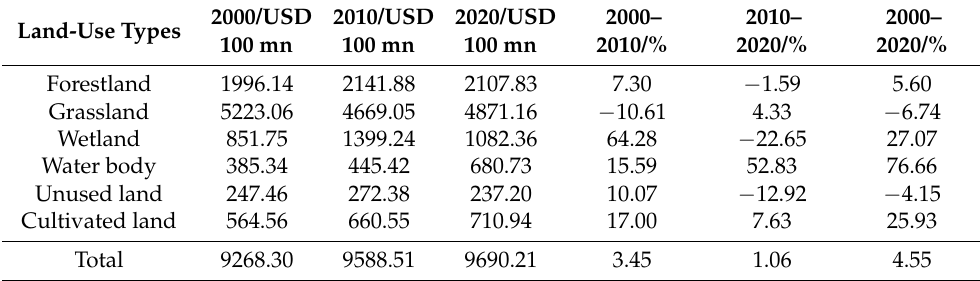
Table 5. Values and changes in ecosystem services in arid and semi-arid ecological regions of China in 2000, 2010, and